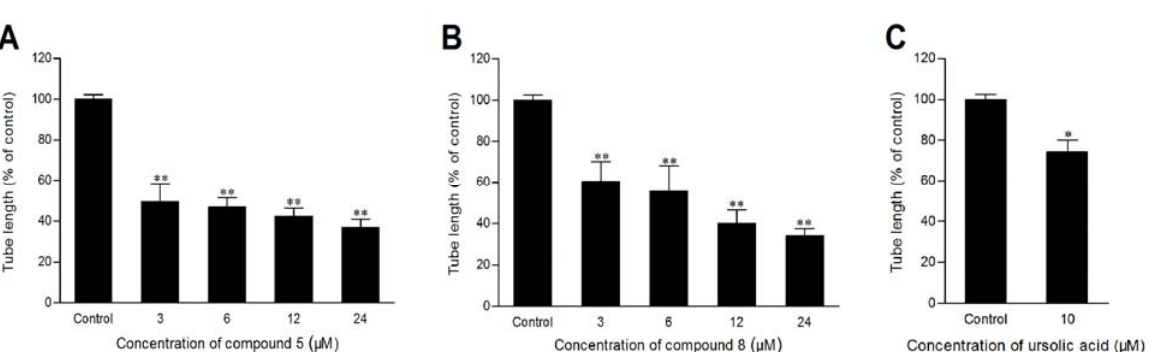
Figure 6. Effect of compounds 5 , compound 8 , and ursolic acid on HUVEC tube formation. A , B , and C : Tube length (% of control) after treatment with compound 5 , compound 8 , and ursolic acid (positive control), respectively. Values are expressed as mean ± SD, n = 4. * p < 0.05, ** p < 0.01 as compared with control. ( D ): The representative photographs of tube networks after treatment with ursolic acid (10 μ M) and compounds 5 and 8 at various concentrations. Bar = 200 μ